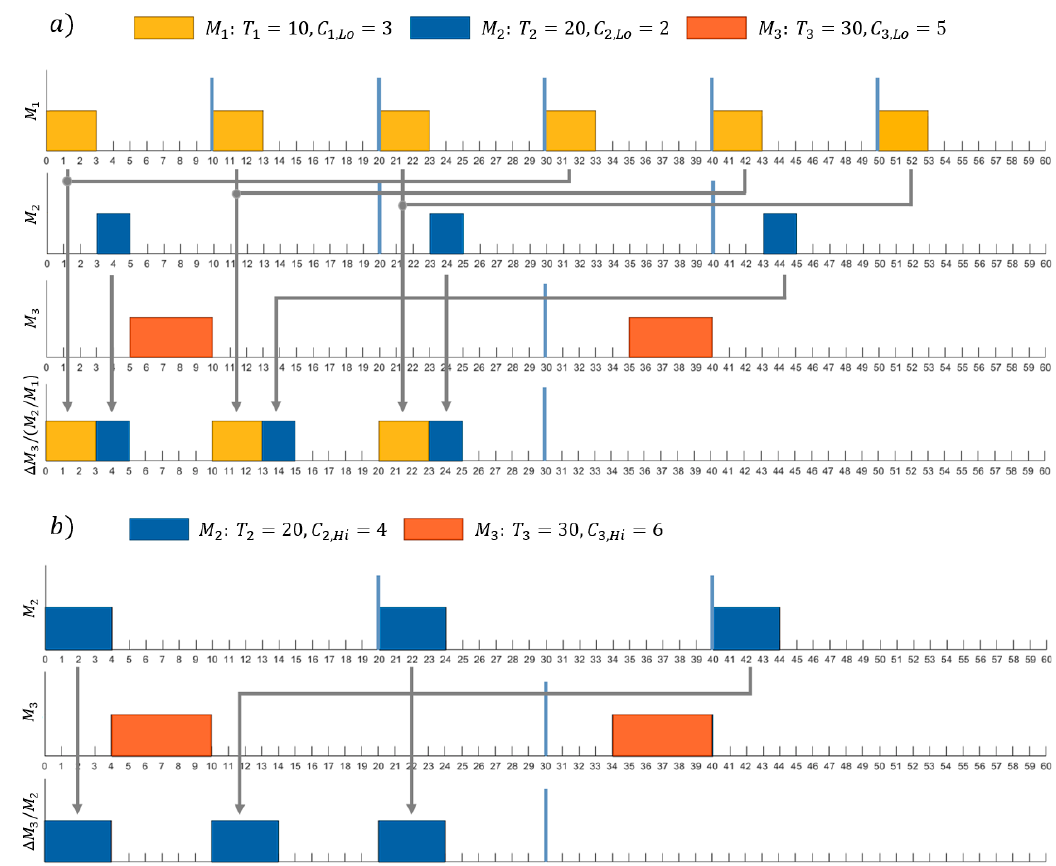
Figure 4. The execution mapping function for the task set example in Table 1 in ( a ) Lo-criticality mode and ( b ) Hi-criticality mode.